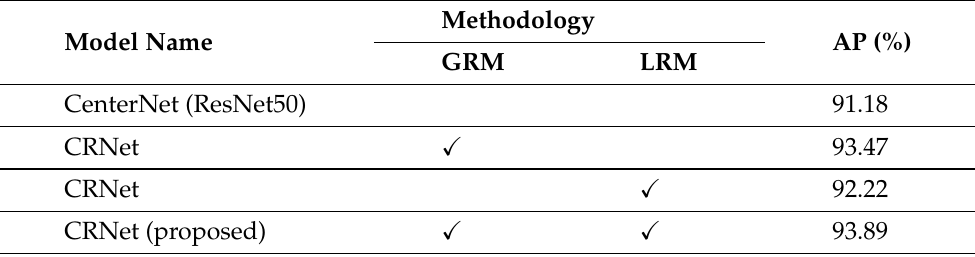
Table 1. The ablation study of CRNet on the Brainwash test